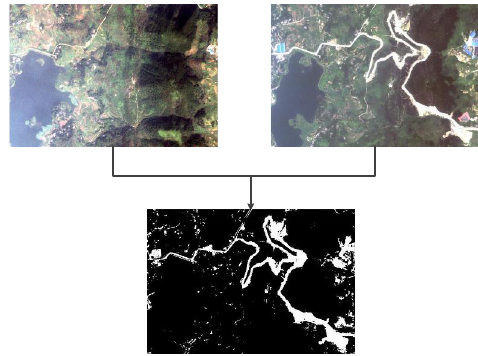
Figure 1-4 Raster to Raster Updating